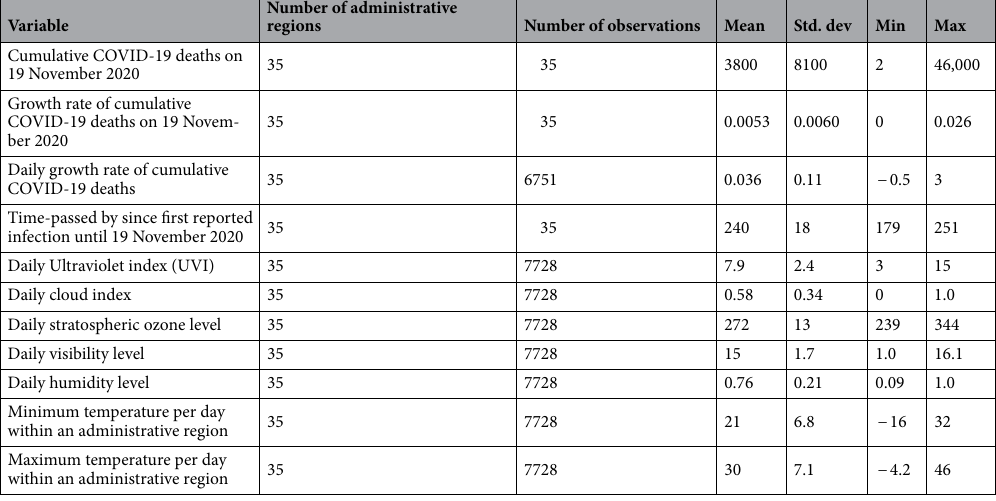
Table 2. Descriptive statistics of the data